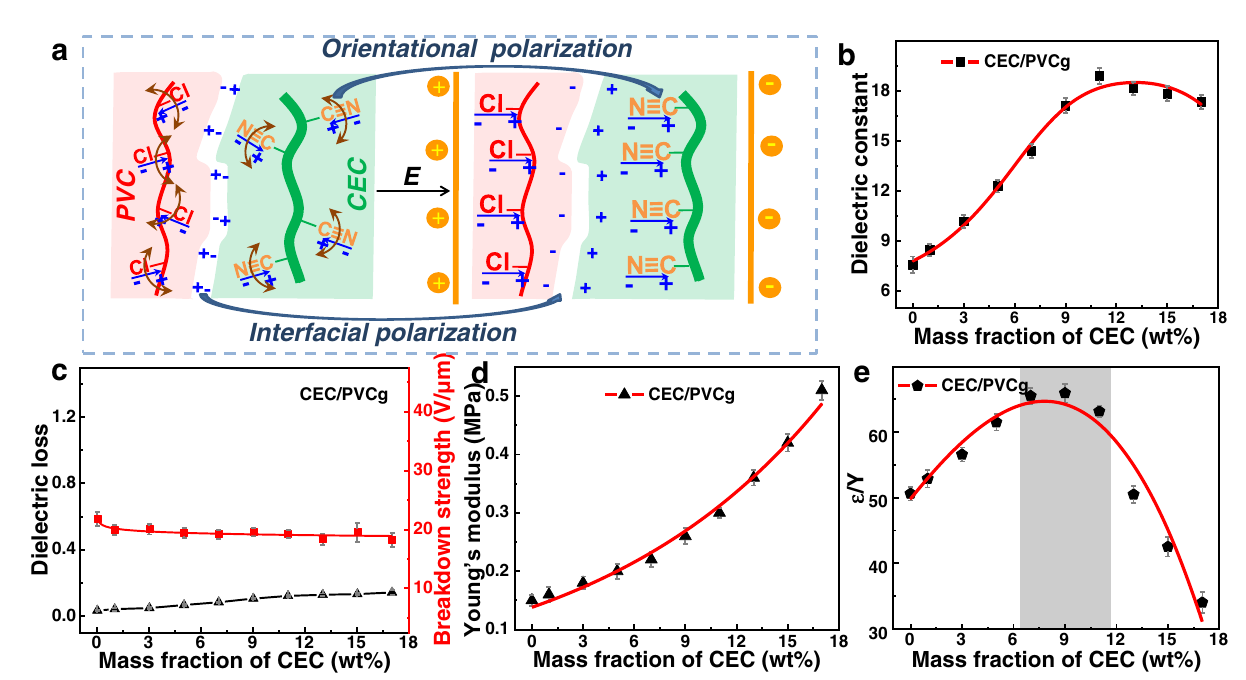
e electromechanicalsensitivity( k = ε /Y ) of CEC/PVCg elastomersat variousloading concentrations ofCEC. The red and green lines represent the PVCand CECchains, respectively. The shading region of e suggests the optimal proportions for pre- paring elastomers. The error bars represent the standard